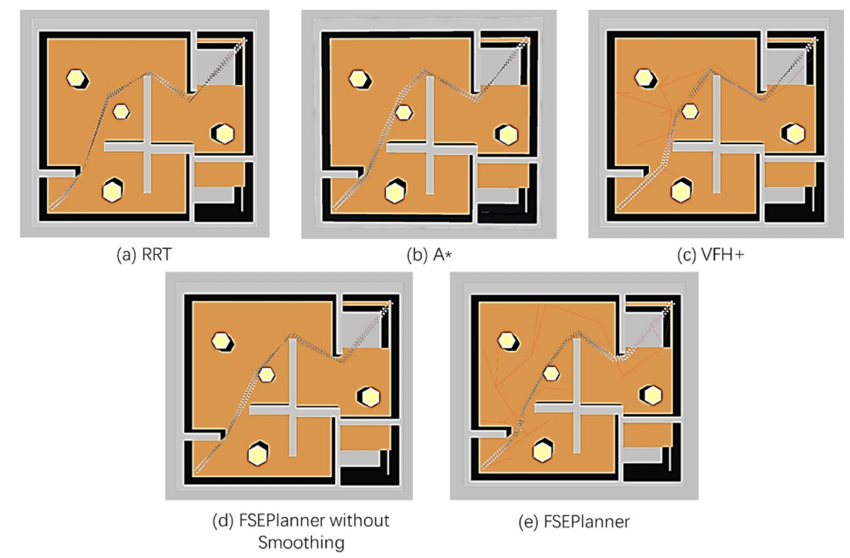
Figure 19. Trajectories of five path planning simulation in maze environment visualization by ( a ) RRT, ( b ) A*, ( c ) VFH+ ( d ) proposed FSEPlanner without Smoothing and ( e ) FSEPlanner algorithm.